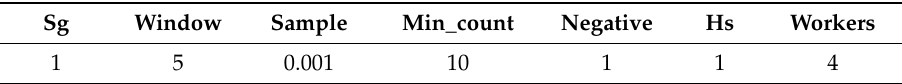
Table 4. Training parameters for Word2Vec.